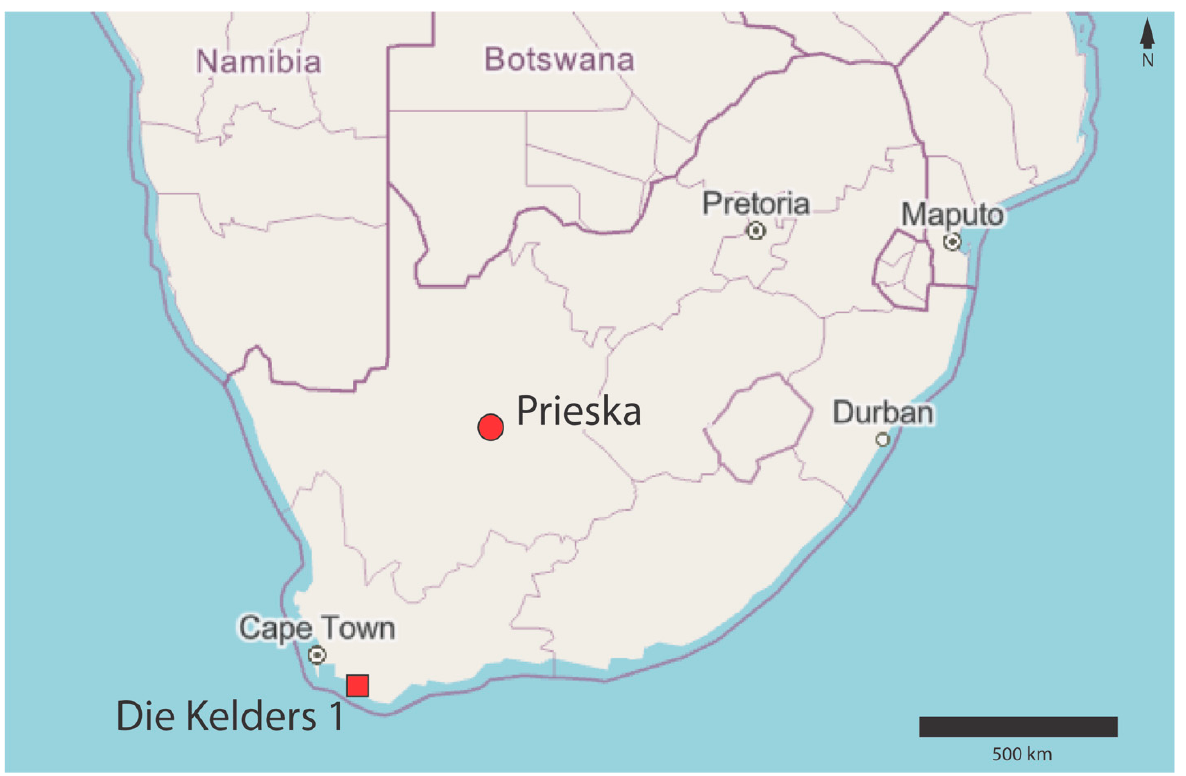
Figure 2. Map of southern Africa showing the locations of Prieska, Northern Cape, where modern sheep were sampled, and Die Kelders 1, the archaeological site from which the ancient specimens were excavated.